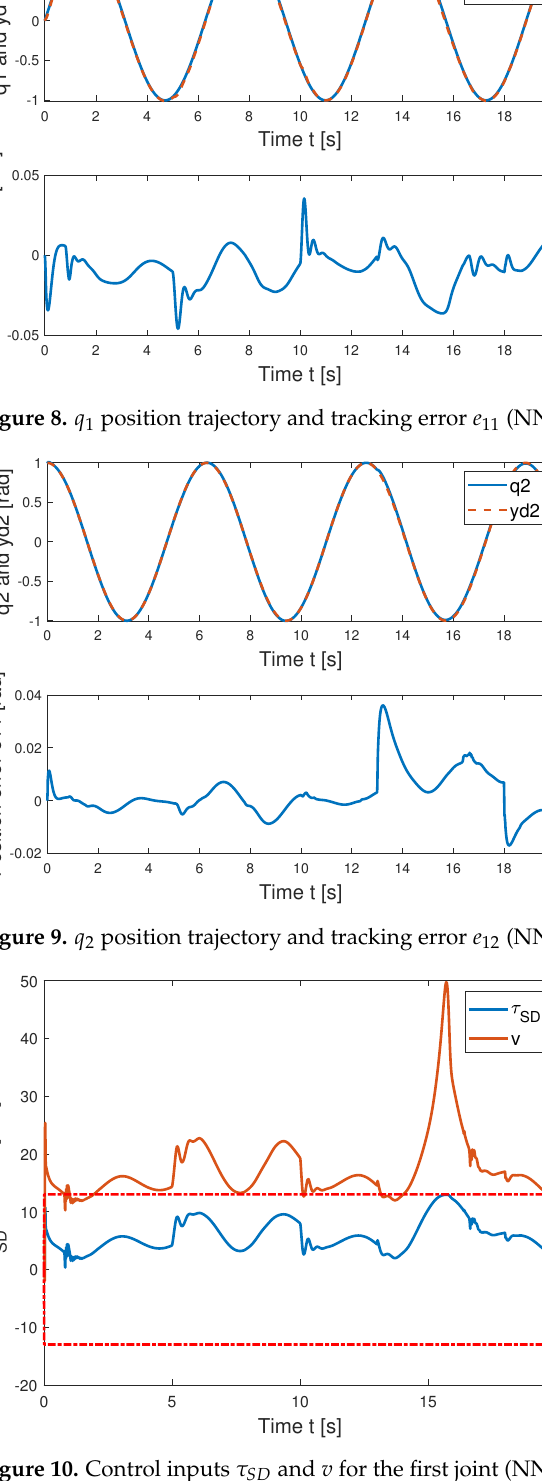
Figure 10. Control inputs τ SD and v for the first joint (NNs-based